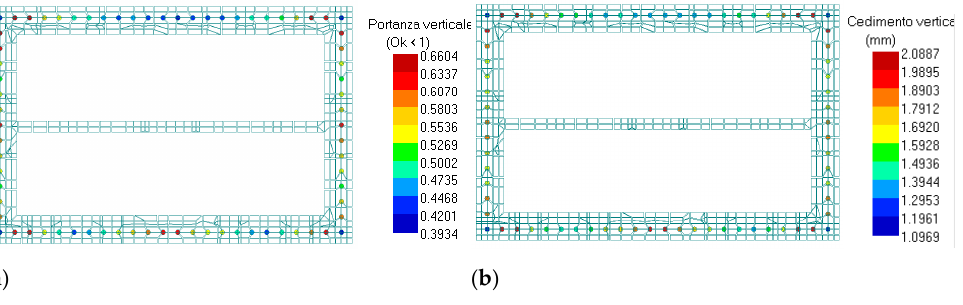
Figure 20. Results of the bearing capacity ( a ) and subsidence ( b ) for the micropiles of the reinforced foundation.